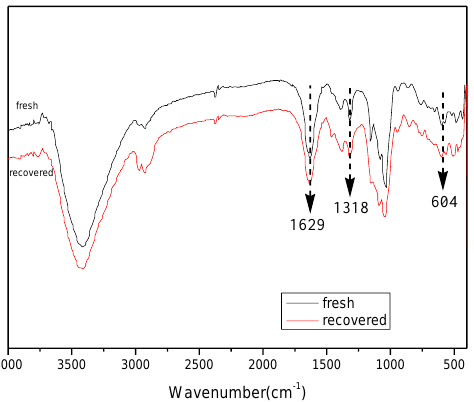
Figure 4. FT − IR spectra of Im-CD1-I and Im-CD1-I after five catalytic runs. Reaction condition: PO (5 mL, 71.5 mmol), Im-CD1-I (0.33 mol%), CO 2 pressure 3 MPa, reaction temperature 110 °C, time 3 h. Table 2. Cycloaddition between CO 2 and various epoxides catalyzed by Im-CD1-I a .